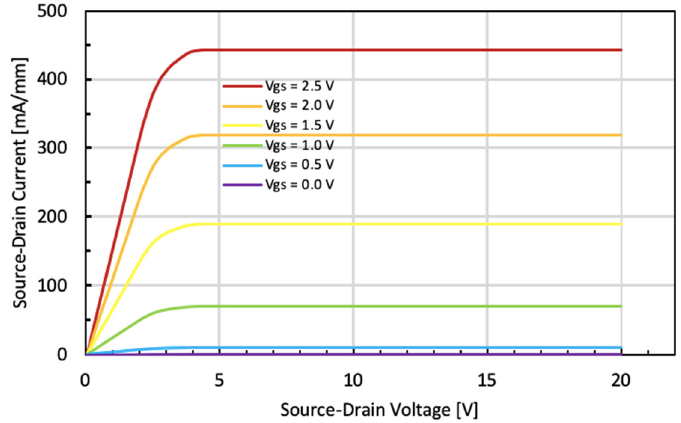
Figure 4. Simulated characteristics for an electrically induced, normally-off HFET. Different gate voltages in steps of 0.5 V, between 0.0 and +2.5 V, have been used.